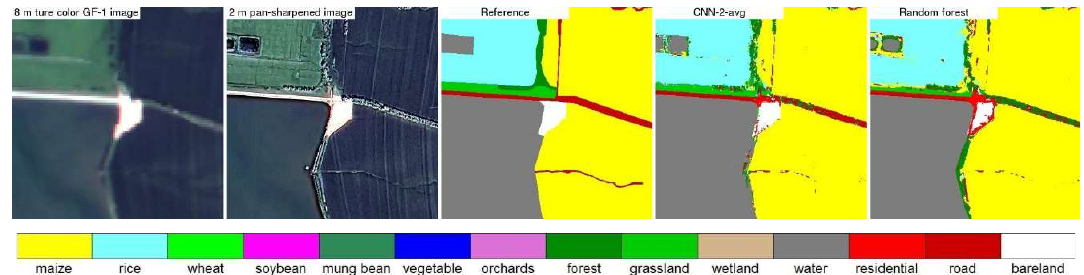
Figure 9. Same as Figure 7 but for the example 400 × 400 pixels in the box area in study area 3 (Figure 3).